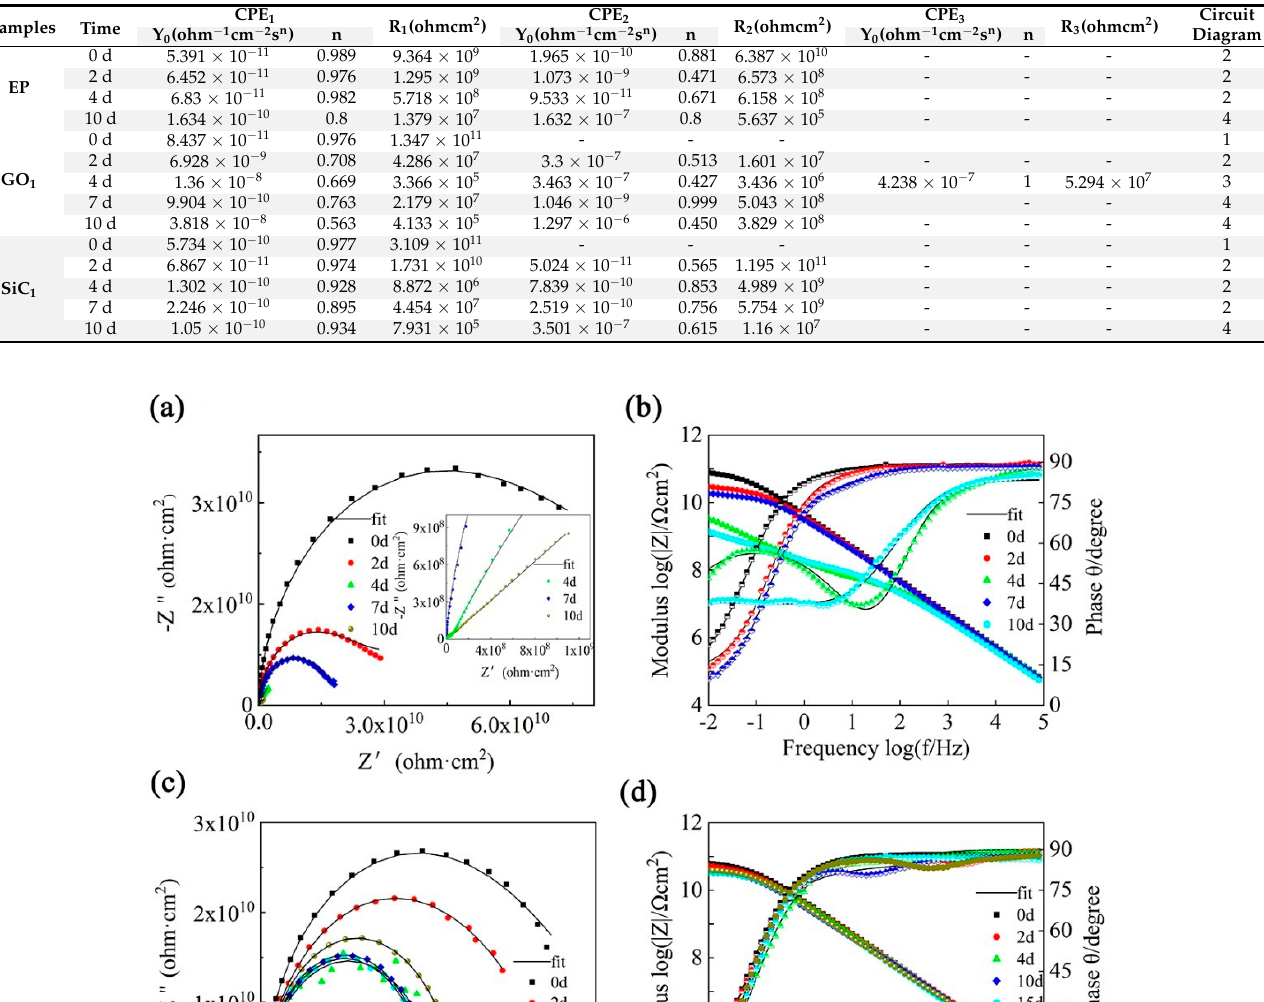
Table 2. EIS data of the EP, GO, and SiC nanocomposite coatings.